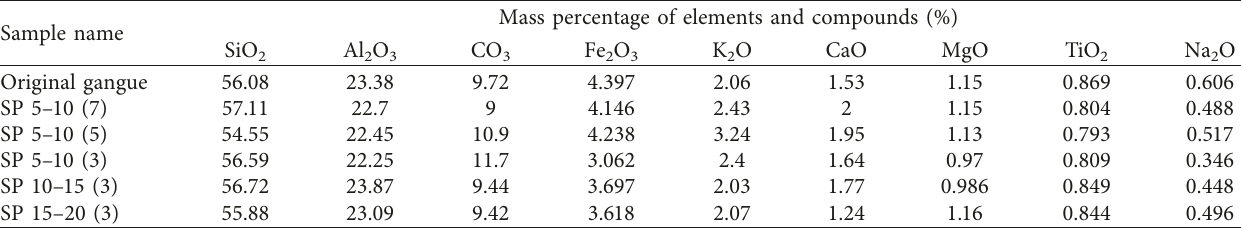
Table 4: Main elements and compounds in granite before and after treatment with water and acidic